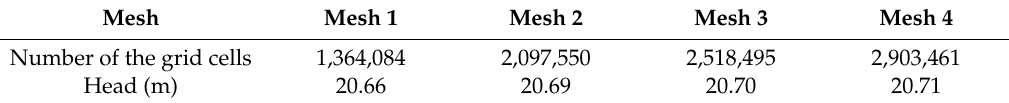
Figure 2. Mesh of the computational domain. Table 2. The grid independence analyzation.